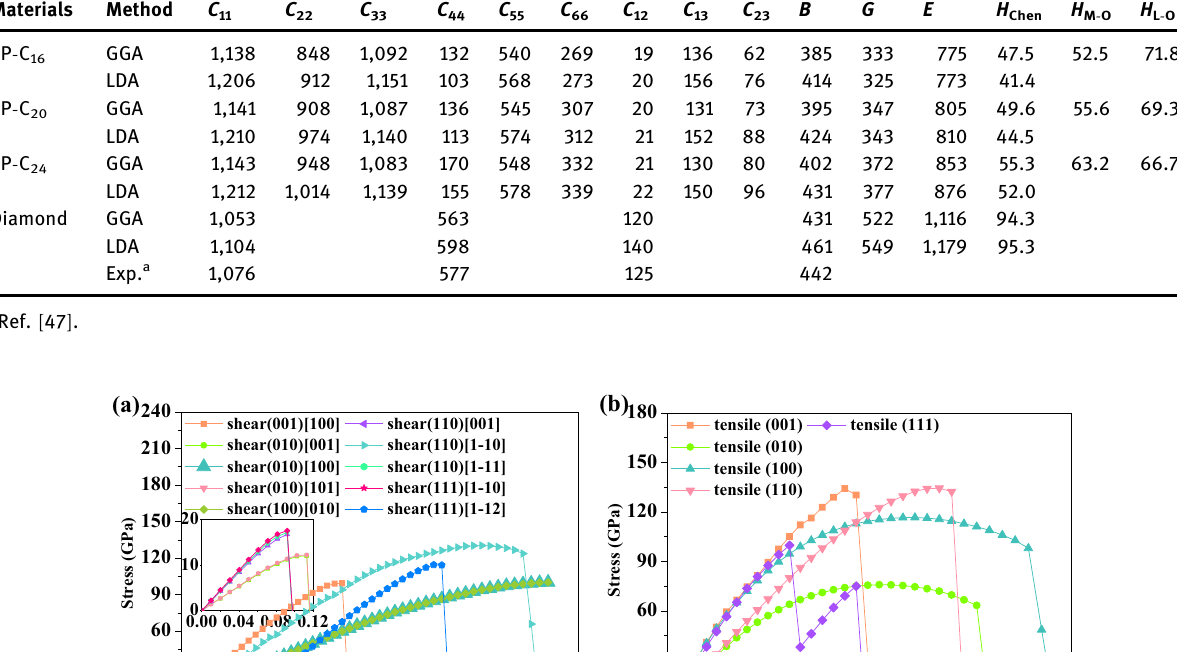
Table 2: The elastic constants ( GPa ) , elastic modulus ( GPa ) , and hardness ( GPa ) of metallic carbon allotropes, c - BN, and diamond Materials Method